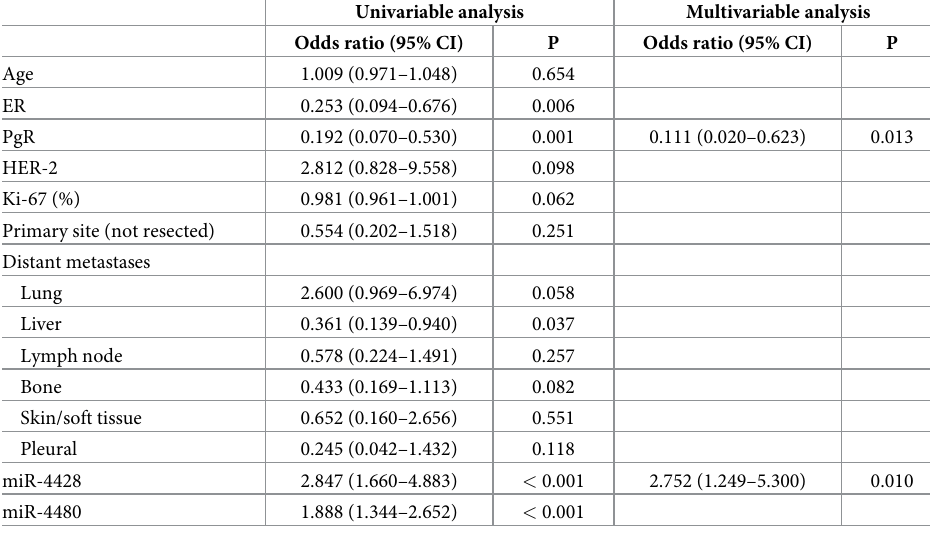
CI, confidence interval; ER, estrogen receptor; HER-2, human epidermal growth factor receptor 2; NA, not applicable; PgR, progesterone